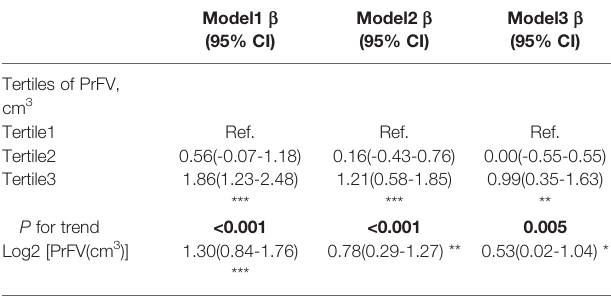
PrFV was log2-transformed for fi tting the generalized linear regression model. Model 1: Unadjusted. Model 2: Adjusted for age and sex. Model 3: Adjusted for age, sex, waist circumference, serum creatinine, and C-reactive protein. PrFV, perirenal fat volume; SUA, serum uric acid; CI, con fi dence interval. ***P < 0.001, **P < 0.01 and *P < 0.05. Statistically signi fi cant p-values were expressed with bold.